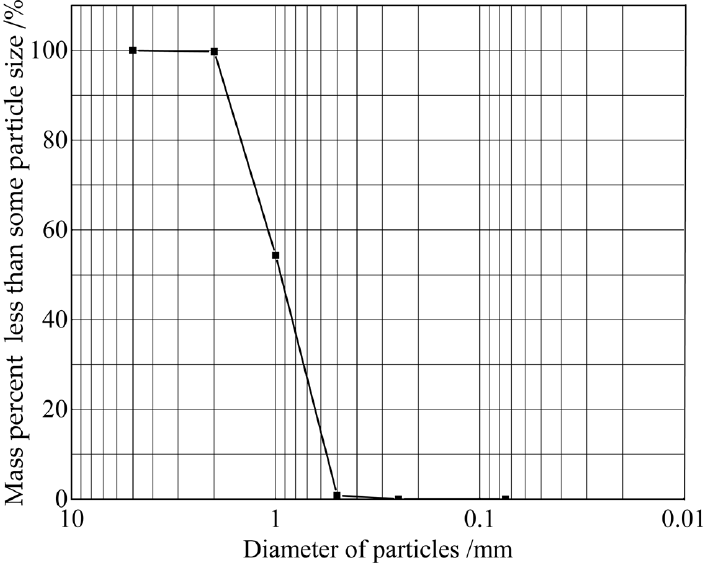
Figure 3. Grading curve of the sand. The friction angle of medium-fine sand is measured to be 34.4 ◦ by direct shear tests. Direct shear tests are also performed on medium-fine sand mixed with 35 mm long fila- ments. The results suggest that when the weight percentages of the filaments are 0.1% and 0.22%, respectively, the filling cohesion is 11 kPa and 25 kPa. The cohesion of fill is changed possible to form weak fiber structures in the soil, which hinder the exertion of soil friction strength, just like the low shear strength of soil with 0.22% filaments. Figure 4 shows the shear strength